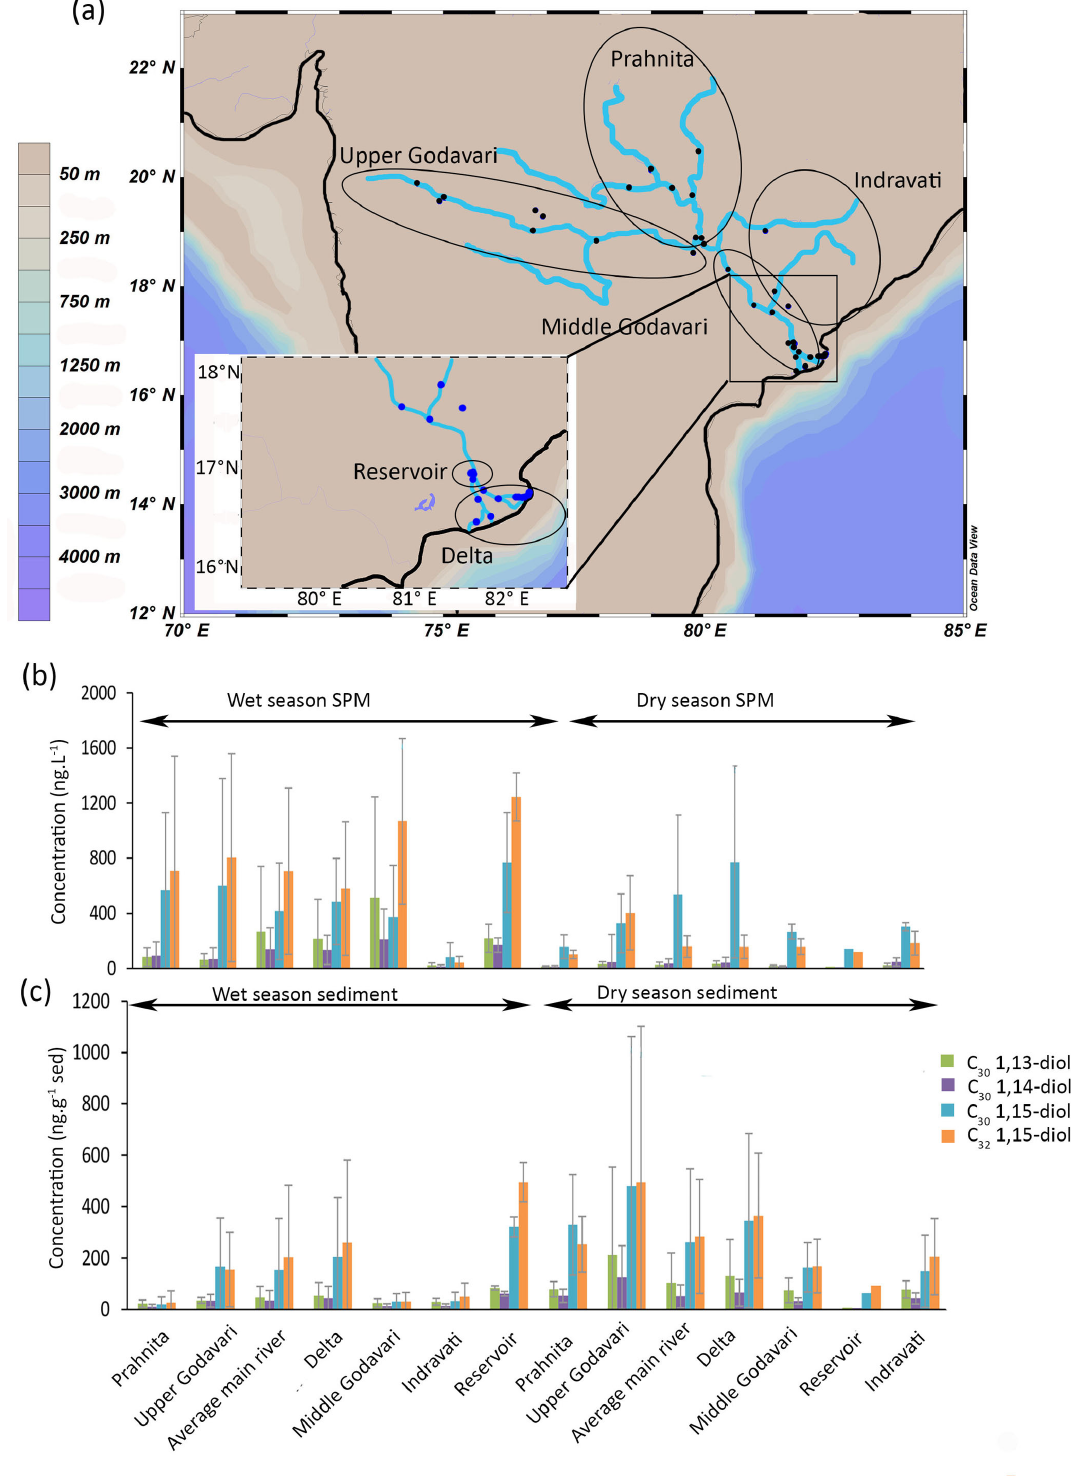
Figure 1. (a) Location of the Godavari samples (Usman et al., 2018) with enhanced view of the delta region, (b) concentrations of LCDs in SPM (collected during wet and dry seasons), and (c) concentrations of LCDs in sediments (collected during wet and dry seasons). Grey bars indicate the standard deviation for each